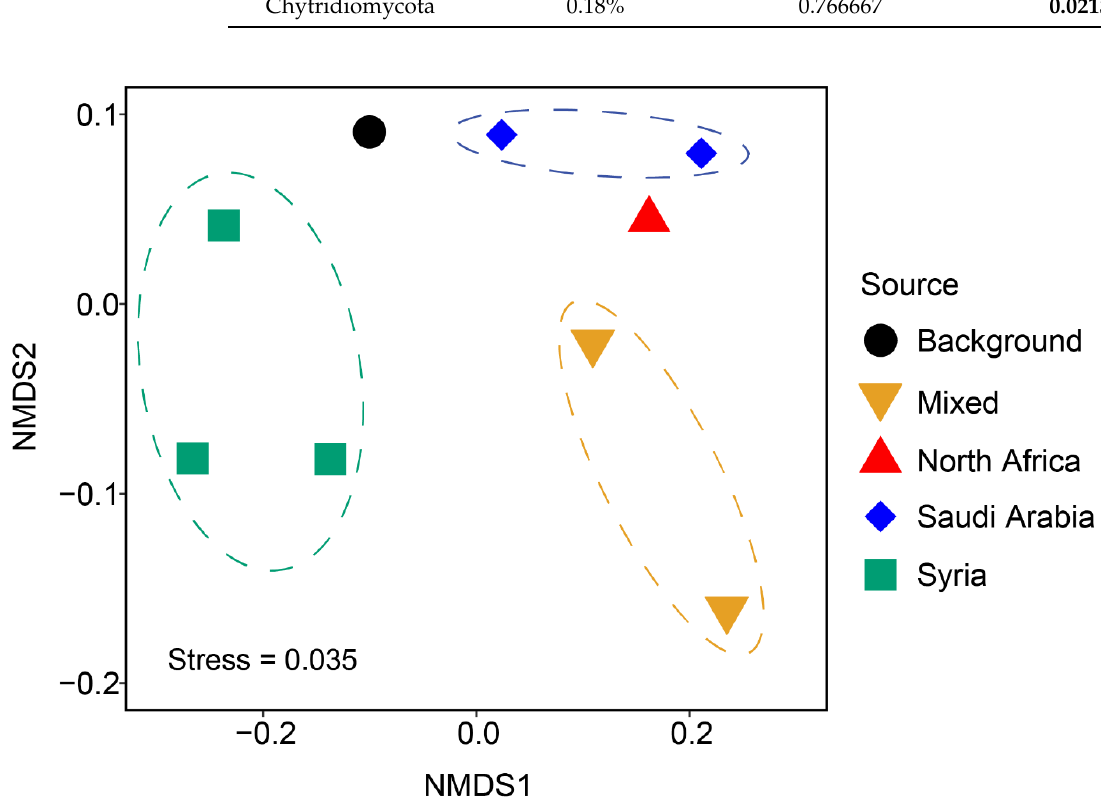
Figure 4. Non-metric multidimensional scaling (NMDS) ordination plot based on the fungal diversity at the class level. The Bray–Curtis distance was calculated and used for the NMDS analysis. The black circle represents samples collected locally (“Background”). The red triangle represents a sample originated from North Africa. Blue diamonds represent samples originated from Saudi Arabia. Green squares represent samples originated from Syria. Yellow inverted triangles represent “Mixed” samples originated from North Africa and other locations (see Supplementary Table S1 for details). The test statistics (R) from the analysis of similarities (ANOSIM) with 9999 free permutations was 0.7537, with a p -value of 0.0025.